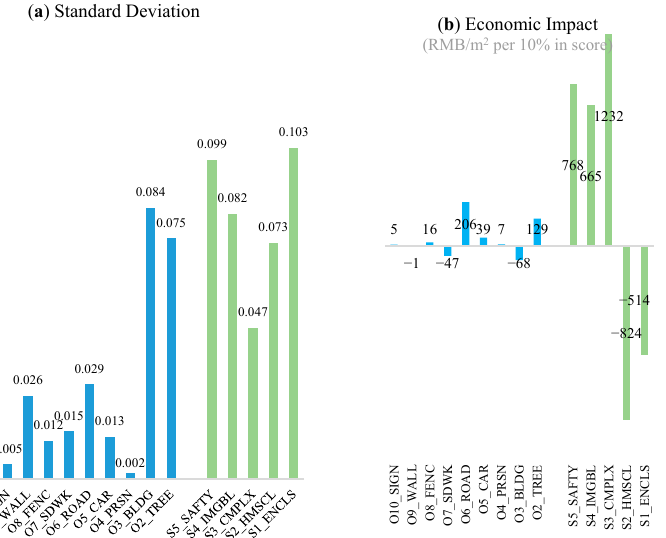
Figure 5. ( a ) Standard deviation of micro-level attributes. ( b ) Economic implications on the property values (RMB/m 2 ) if increasing scores by 10%.